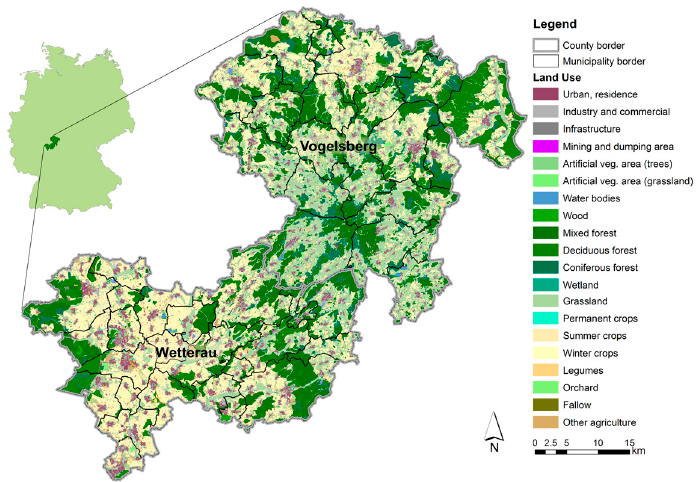
Figure 1. Map of the spatial position and land-use of the counties Vogelsberg and Wetterau in Germany including municipality borders [42,43].